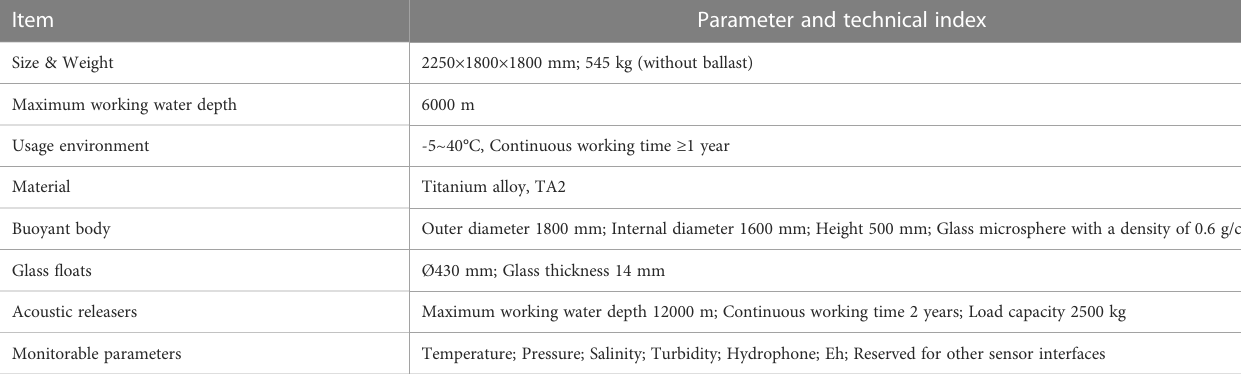
TABLE 1 Technical indexes of 6000-meter double decelerating lander.